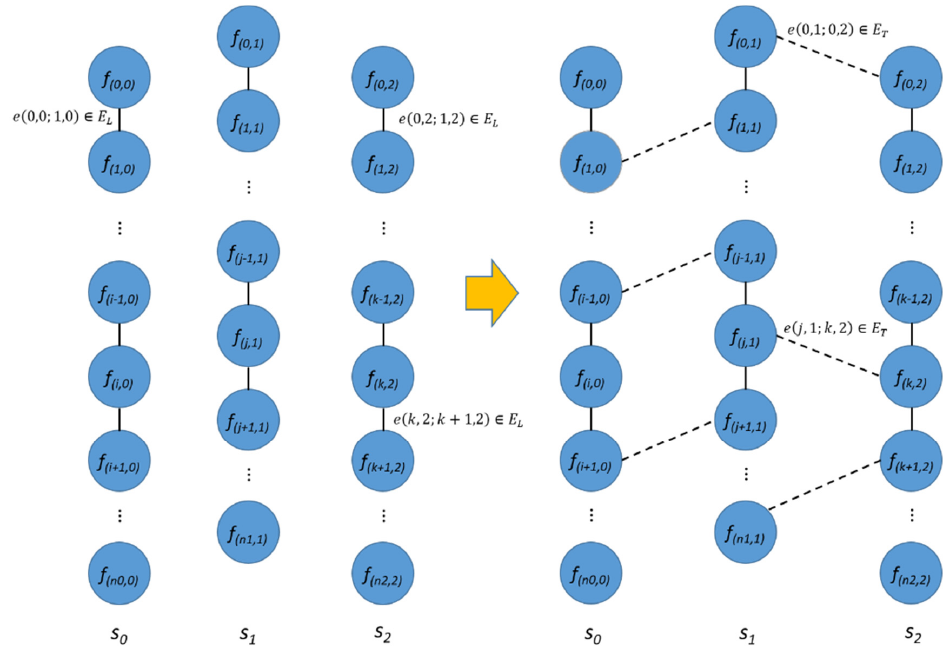
Sensors 2020 , 20 , x FOR PEER REVIEW Figure 5. Image sequences and an adjacency graph with sets of edges EL and ET. Figure 5. Image sequences and an adjacency graph with sets of edges EL and ET.